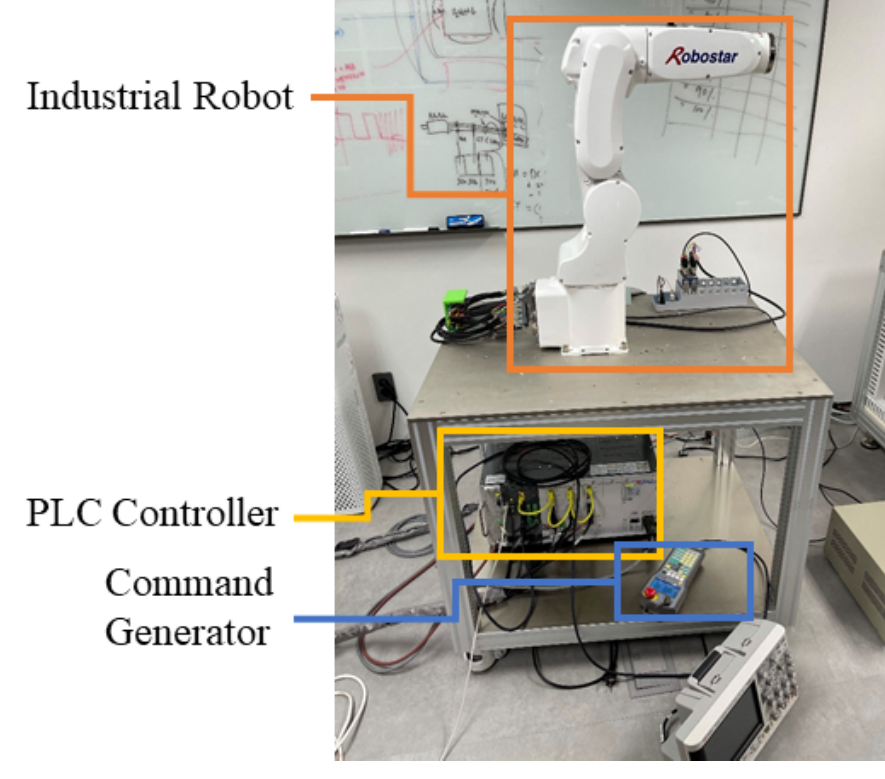
Figure 3. Experimental Setup for Robostar R004.